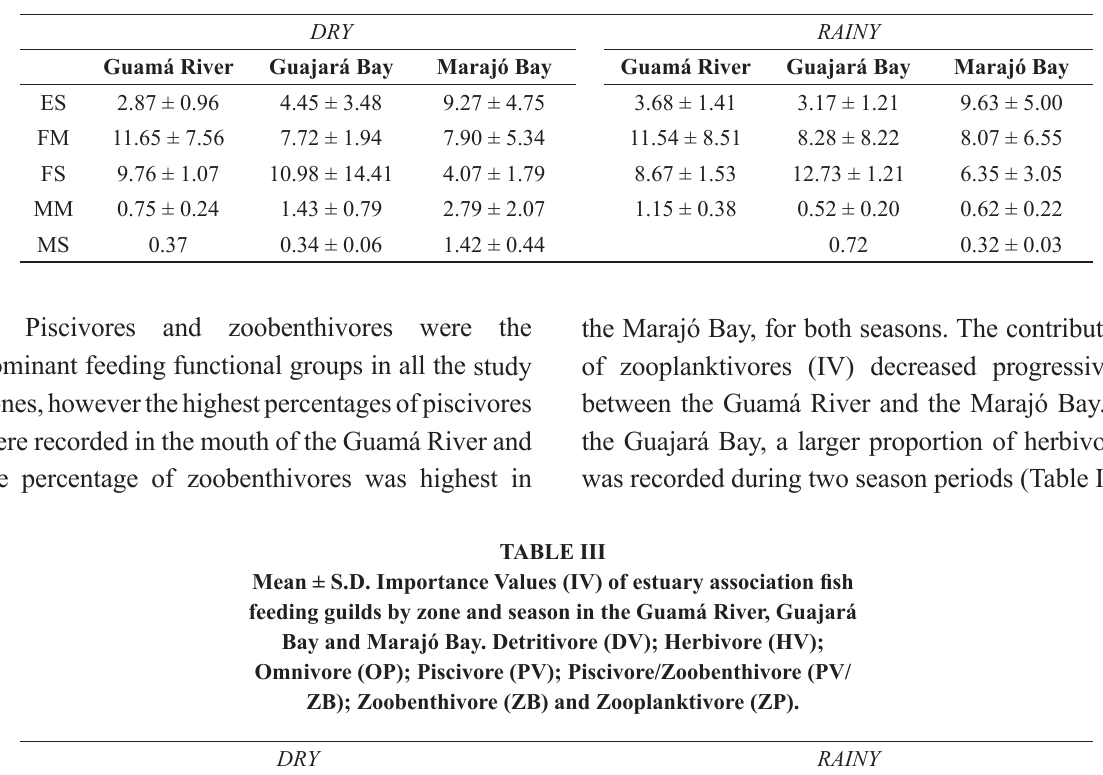
Mean ± S.D. Importance Values (IV) of estuary association fish environment guilds by zone and season in the Guamá River, Guajará Bay and Marajó Bay. Estuarine Species (ES); Freshwater Migrants (FM); Freshwater Stragglers (FS) Marine Migrants (MM) and Marine Stragglers (MS).